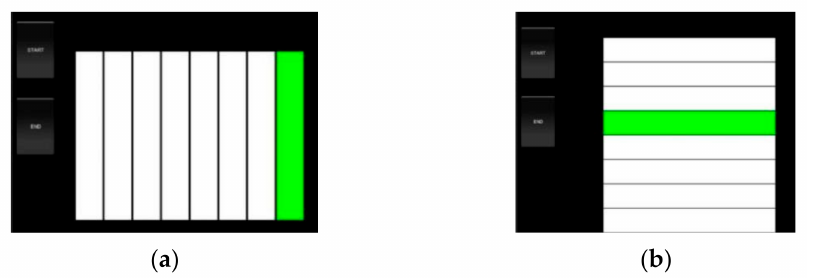
Figure 2. The beginning interface of the pilot experiment: ( a ) the horizontal experiment; ( b ) the vertical